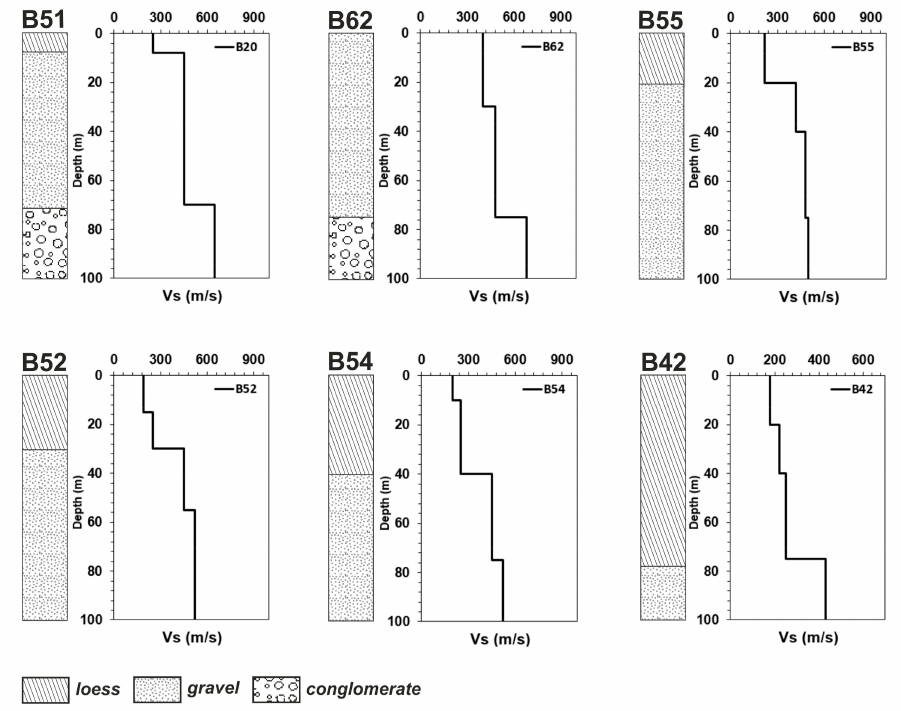
Figure 5. The borehole and downhole logs of the invasive technique based on the study of [29] allowed the determination of the shear-wave velocity profile with depth V S of the cross-section cutting through Dushanbe from west to east (Figure